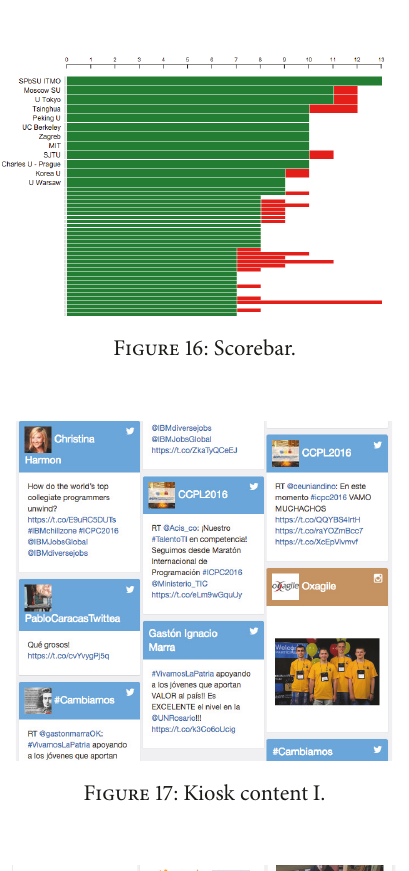
Figure 12: Scoreboard real-time updates.